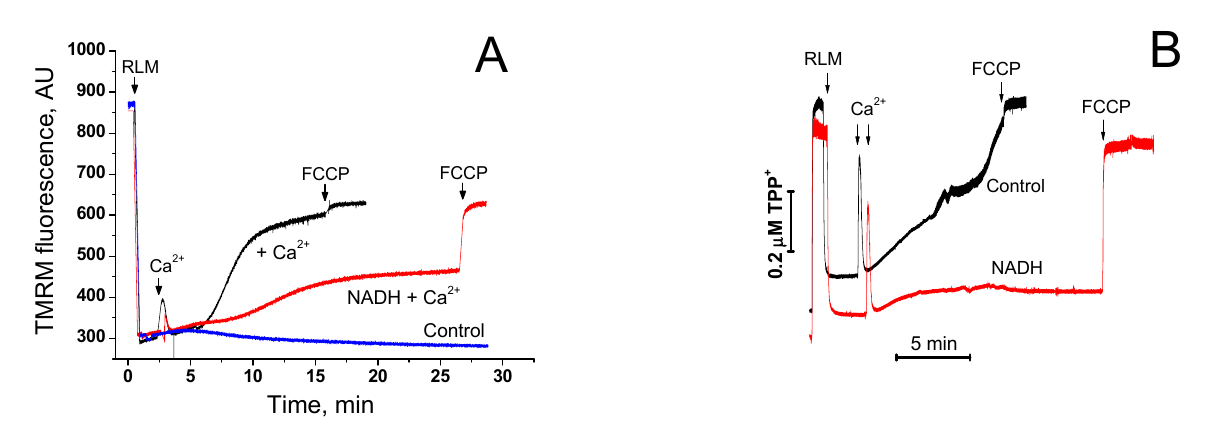
Figure 6. Effect of NADH on the Ca 2+ -dependent dissipation of ∆Ψ m in mitochondrial suspension. Prior to the measurements, 150 nM TMRM ( A ) or 1 µ M TPP + ( B ) were added to KCl-BM. Arrows show the addition of RLM (0.3 ( A ) and 1 mg prot./mL ( B ), 50 ( A ) and 200 µ M Ca 2+ ( B ), and 500 nM FCCP. Each panel provides representative curves of one experiment of three similar.